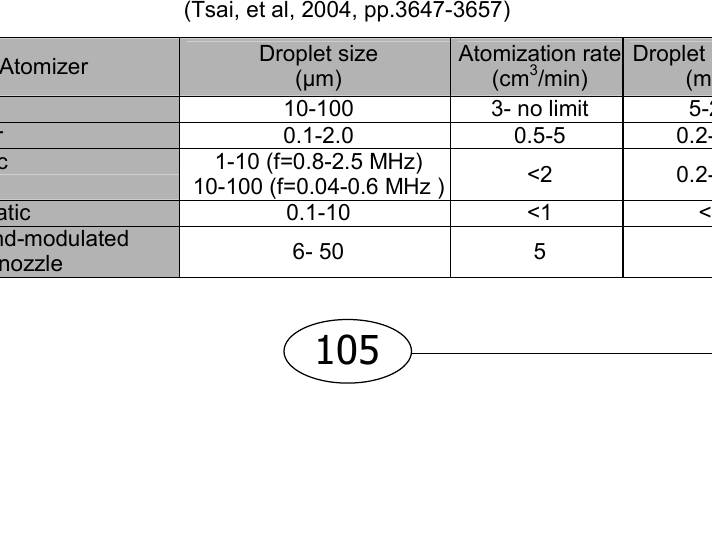
Table 2 – Characteristics of the atomizers used for the SP method (Tsai, et al, 2004,